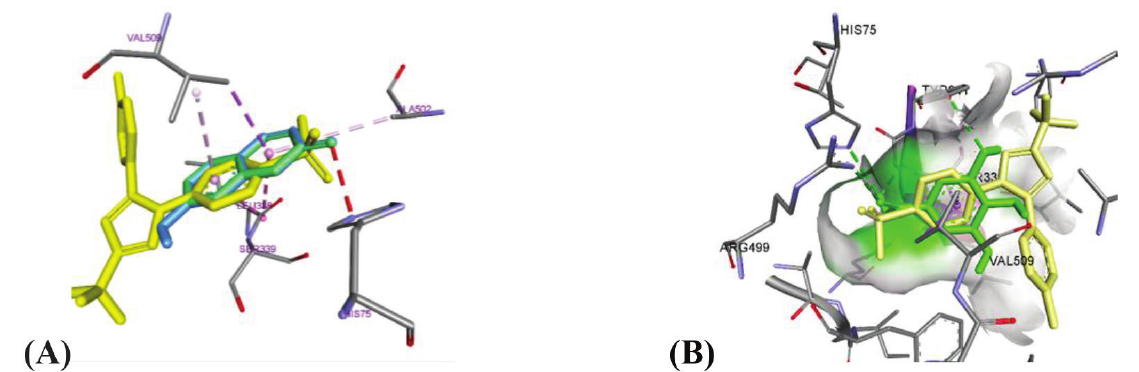
Figure 9. Visualization of celecoxib compatible conformation with ( A ) coumarin (blue) and umbelliferone (green) ( B ) gallic acid (green molecule) in the СОХ-2 active